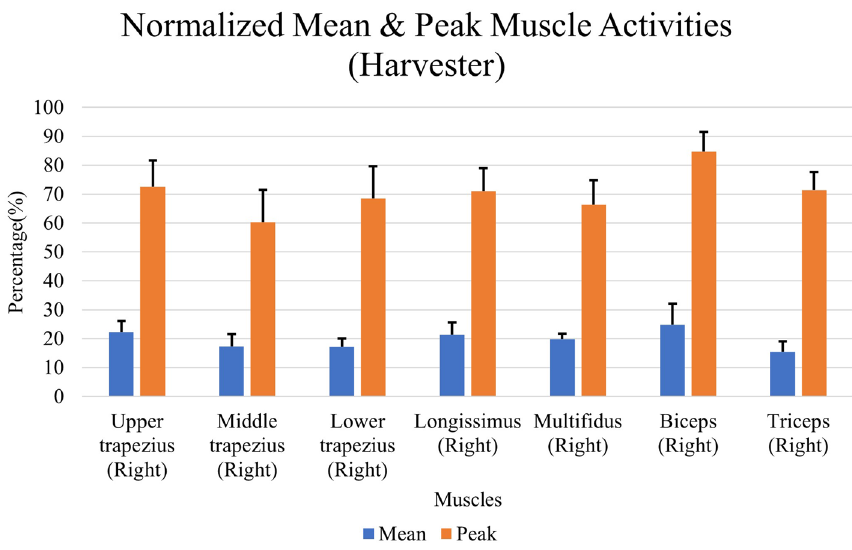
Figure 4. The average mean and peak muscle activities during FFB